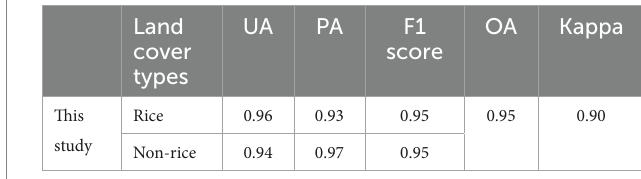
TABLE 4 Accuracy assessment of rice fields map in 2020.